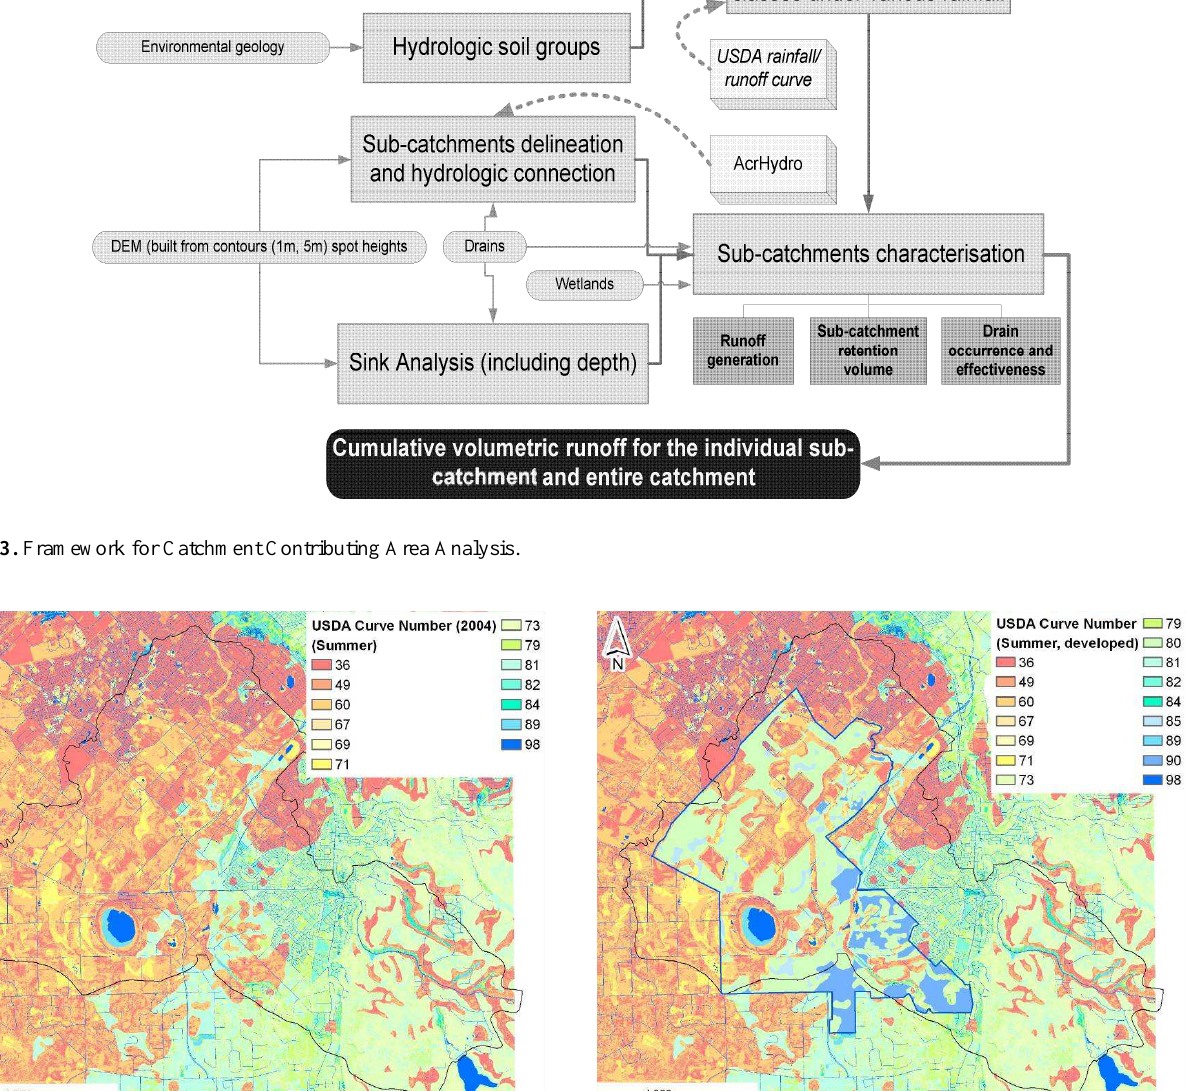
(b) Figure 4. USDA Curves applied to the volumetric runoff analysis for (a) predevelopment and (b) post-development conditions